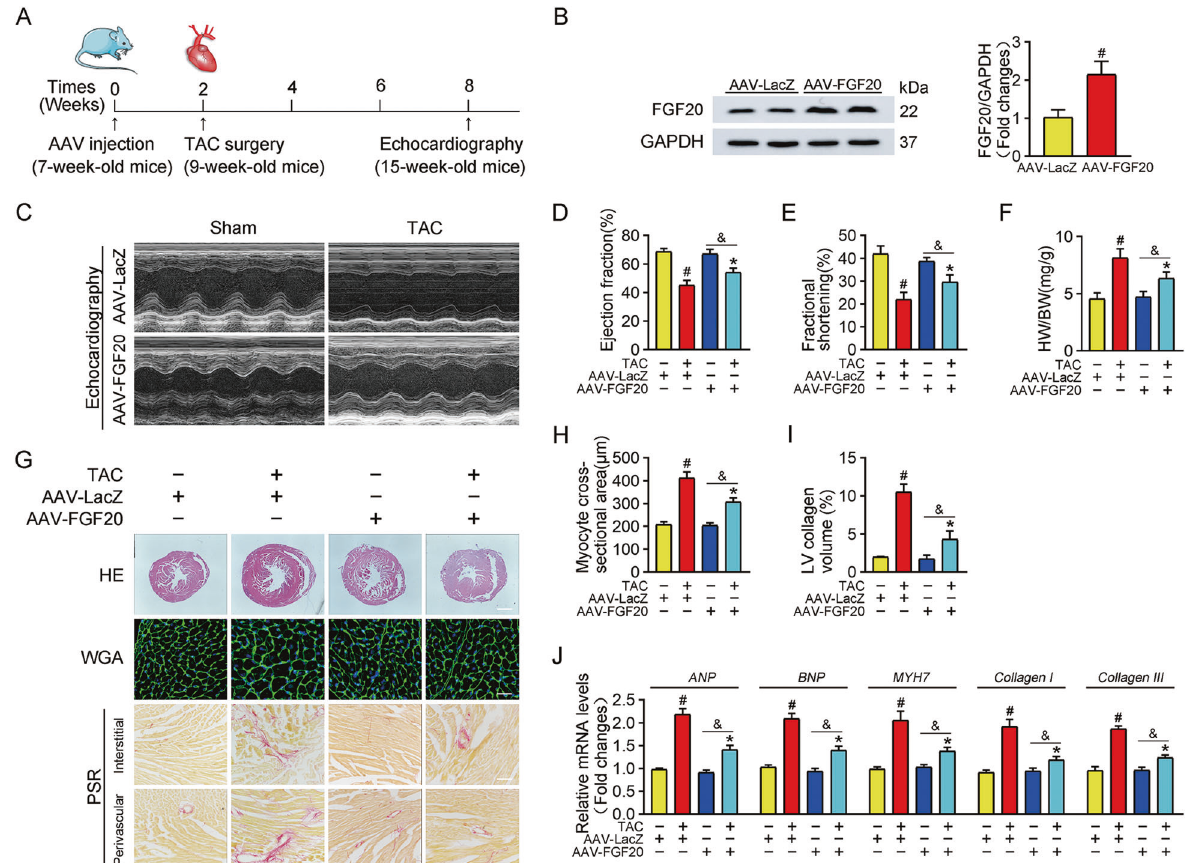
Fig. 3 Cardiac FGF20 ameliorates TAC-induced cardiac dysfunction and hypertrophy in vivo. A Schematic diagram demonstrating the animal experiment design. B Western blot was performed and quantitatively analyzed to determine the protein levels of FGF20 in the hearts of mice transfected with AAV harboring FGF20 RNA under the cTnT promoter (AAV-FGF20) or a control vector negative control (AAV-LacZ) by myocardial injection. C Representative M-mode echocardiographic recording obtained from mice infected with AAV-LacZ or AAV-FGF20 and subjected Sham or TAC operation. D – F Quantitative analysis of LV ejection fraction (EF), fractional shortening (FS) and heart-to-body weight ratio (HW/BW), respectively. G HE staining (Scale bar = 0.8 mm) and WGA staining (Scale bar = 30 μ m) were performed to detect cardiac hypertrophy, and PSR staining (Scale bar = 200 μ m) was were performed to detect cardiac fi brosis of mice infected with AAV-LacZ or AAV- FGF20 and subjected Sham or TAC operation. H Quantitative analysis of cardiomyocyte cross-sectional areas (CSA) in G . I Quantitative analysis of LV collagen volume in G . J RT-qPCR analysis of the mRNA levels of hypertrophic marker genes ( ANP, BNP , and MYH7 ) and fi brosis marker genes ( Collagen I and Collagen III ) in the hearts of mice infected with AAV-LacZ or AAV-FGF20 and subjected Sham or TAC operation. n = 5 per group, # P < 0.05 versus AAV-LacZ + Sham group, * P < 0.05 versus AAV-LacZ + TAC group, & P < 0.05 versus AAV-FGF20 + Sham group. Data represent means ± SEM, Two-tailed Student ’ s t